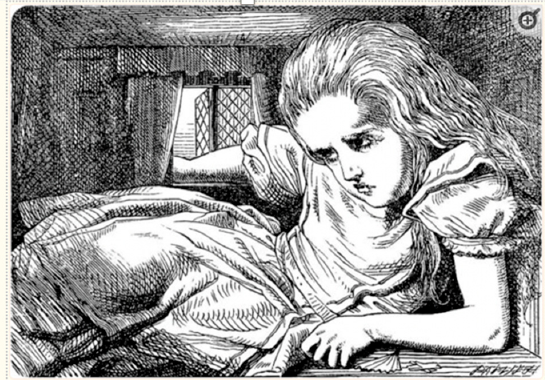
Figure 1. Alice experiences total-body macrosomatognosia. Illustrated by John Tenniel (1865).